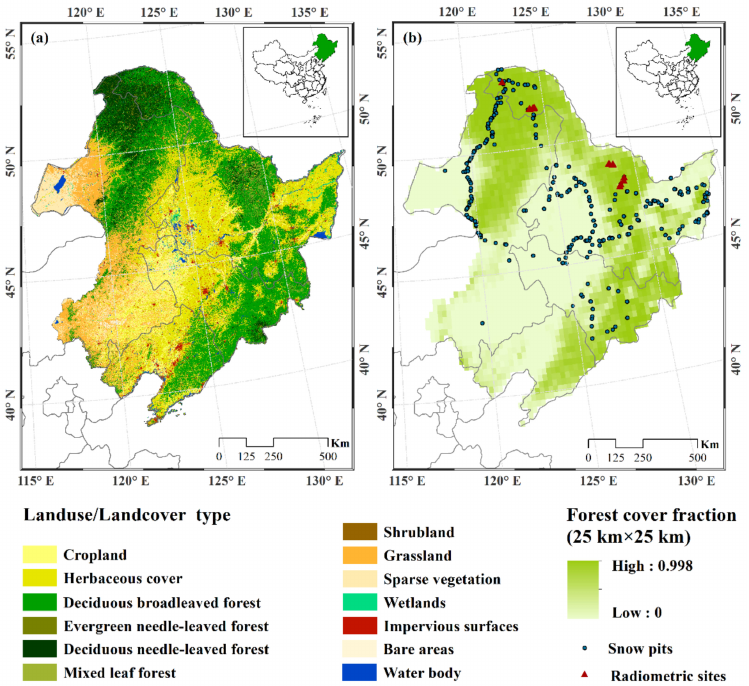
Figure 1. ( a ) Geographical location of the study area marked with GLC_FCS30-2015 global land-cover maps, ( b ) forest distribution of Northeast